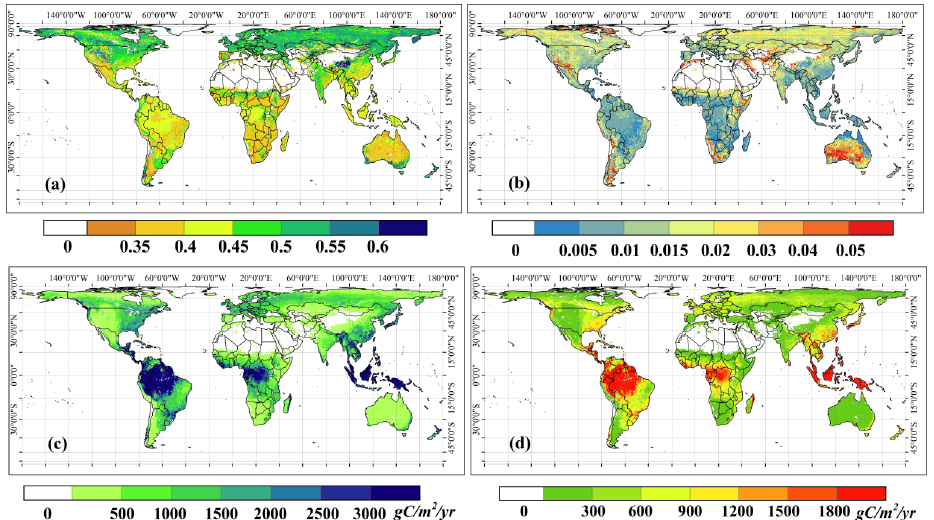
Figure 1. The spatial pattern of the ( a ) annual averaged CUE, ( b ) standard deviations of CUE, ( c ) GPP, and ( d ) Ra during 1982–2016.